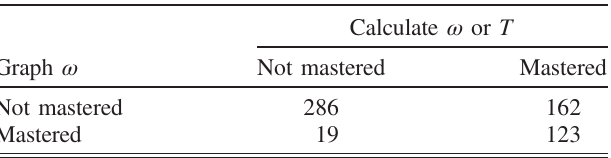
TABLE III. Cross tabulation for the mastery of graph ω and calculate ω or T skills. Here we see indication of the hierarchy graph ω → calculate ω or T